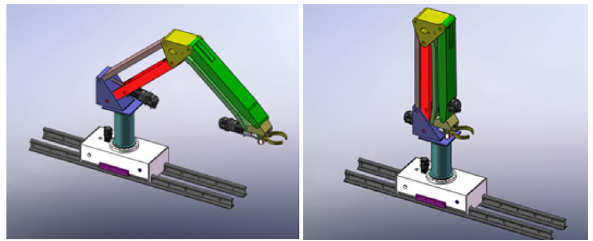
Fig. 1 Overall structure of a drill pipe